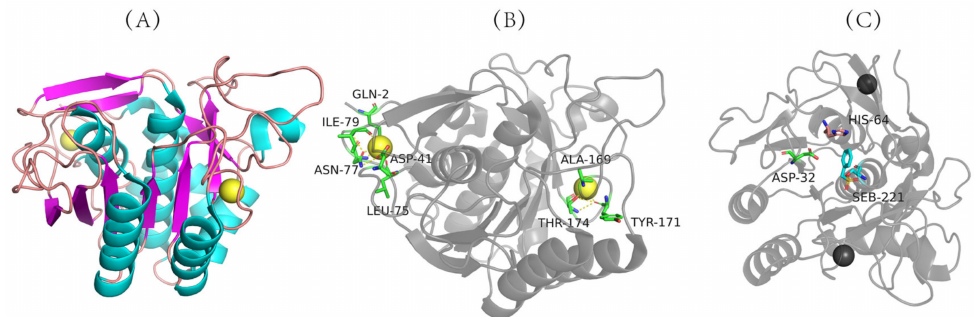
Figure 2. Three-dimensional structure of nattokinase. ( A ) Calcium binding site of nattokinase. ( B ) Three-dimensional structure of nattokinase. ( C ) Nattokinase triple catalyst. Nattokinase struc- ture diagram taken from https://www.rcsb.org/structure/4DWW with modifications (accessed on 14 March